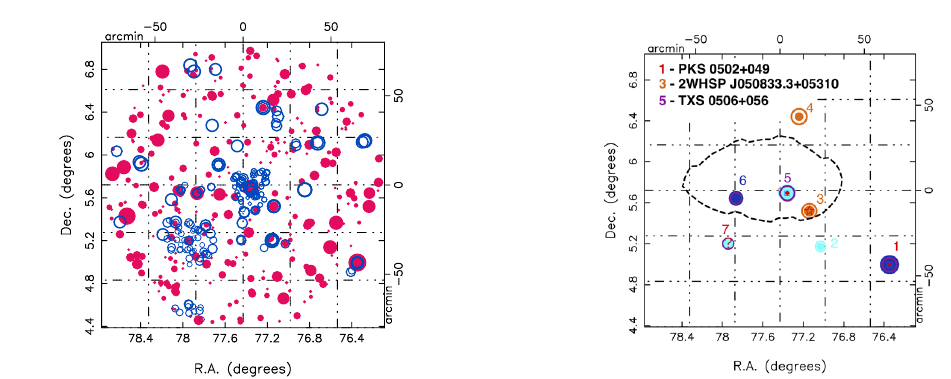
Figure 1. Left : Radio and X-ray sources within 80 arc-minutes of the position of IceCube-170922A. Symbol diameters are proportional to source intensity. Radio sources appear as red filled circles, X-ray sources as open blue circles. Right : Known and candidate blazars around IceCube-170922A. Dark blue circles represent LBL type candidates, cyan symbols are for IBL candidates, and orange symbols are for HBL candidates. Known blazars are marked by a red diamond if they are included in the BZCAT catalogue or a star if they are part of the 2WHSP sample. The dashed line shows the 90% error contour of IceCube-170922A.